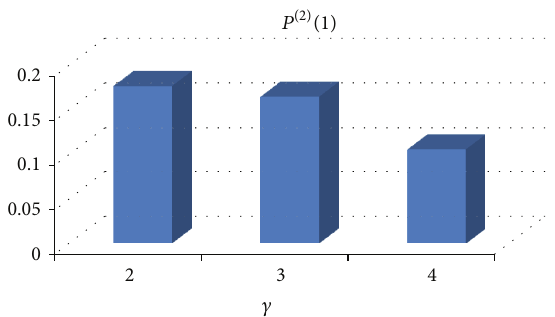
Figure 3: Effect of reneging 𝛾 on the probability that the server is providing service in mode 2 (when 𝛽 = 6 , 𝛼 = 4 , 𝜂 = 5, 4, 3) .